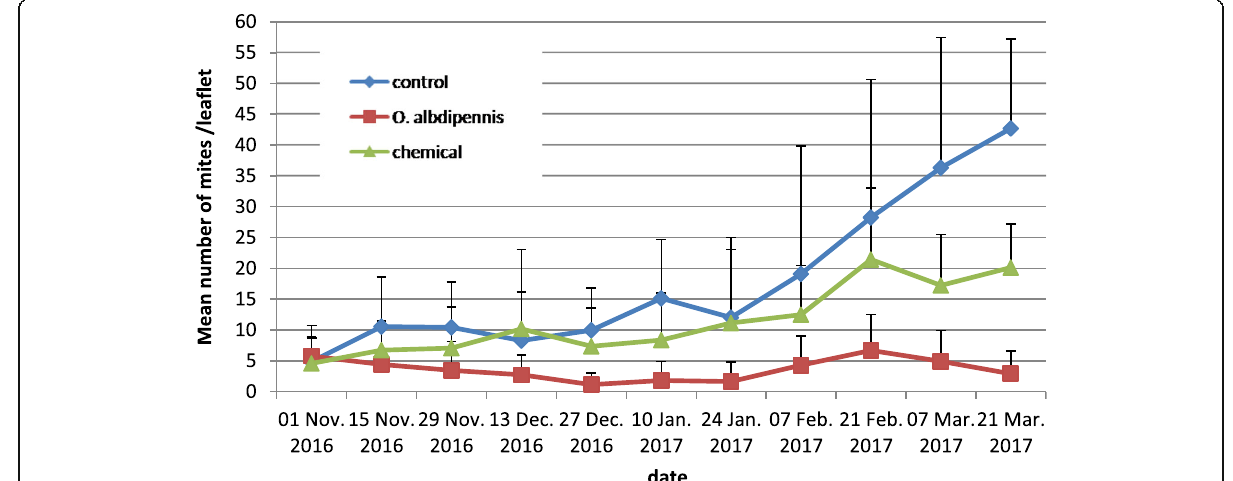
Fig. 2 Mean numbers of T. urticae /leaflet when controlled by two different (releasing predators and chemical pesticides) methods in a sweet pepper greenhouse during the winter plantation of 2016 – 2017